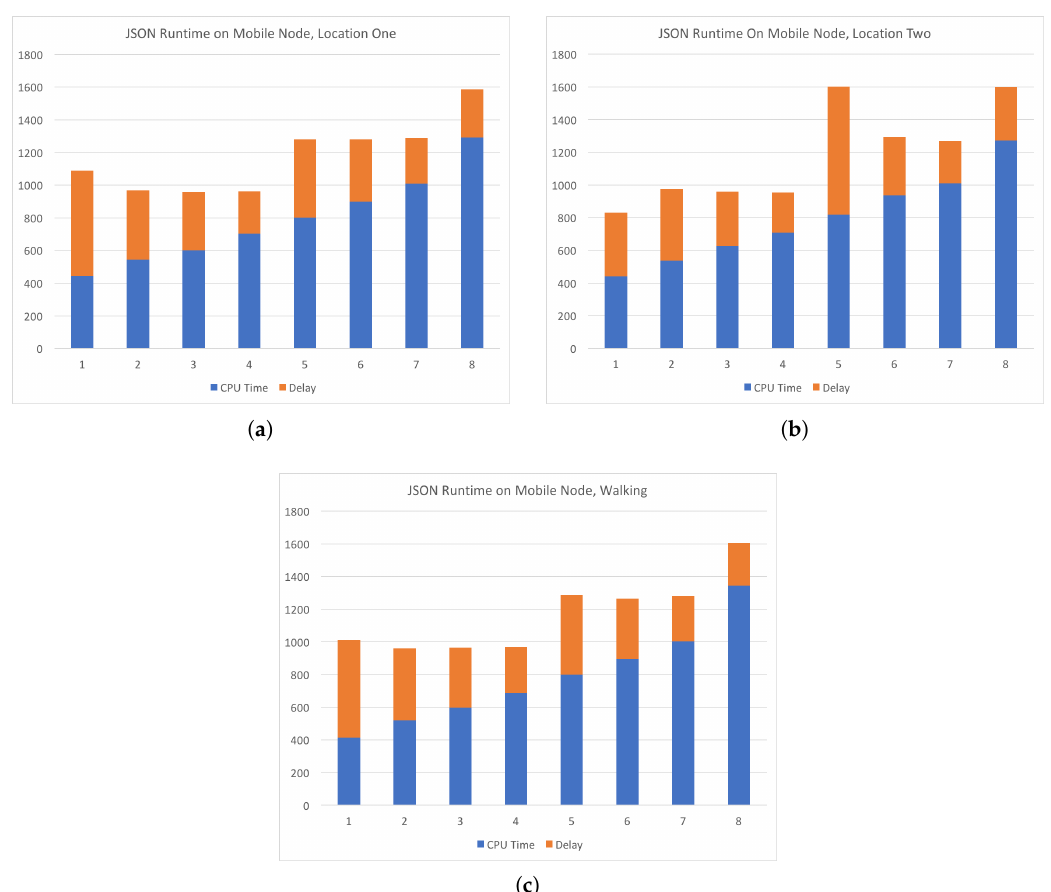
Figure 9. Comparison of CPU time and delay for requests made from a mobile device to the “central” server location. ( a ) and ( b ) are requests made while stationary at two locations and the results in ( c ) were obtained while walking between the two locations.